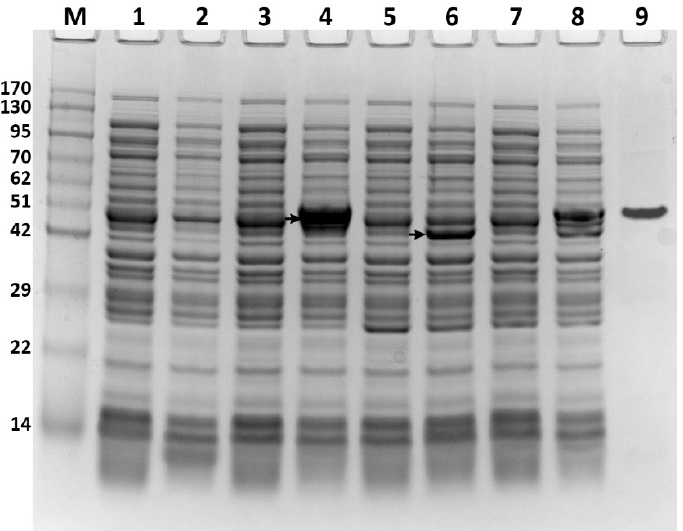
Figure 2. Analysis of the AtFab2 and AtFatA proteins expressed in E. coli by SDS-PAGE. Recombinant protein expression was induced by 0.1 mM IPTG for 3 h at 37 °C. Lane M, pre-stained protein molecular weight ladder; lane 1, uninduced cells extracts from E. coli BL21(DE3) harboring pET30a(+); lane 2, induced cells extracts from E. coli BL21(DE3) harboring pET30a(+); lane 3, uninduced cells extracts from E. coli BL21(DE3) harboring pET-AtFab2; lane 4, induced cells extracts from E. coli BL21(DE3) harboring pET-AtFab2; lane 5, uninduced cells extracts from E. coli BL21(DE3) harboring pACYC-AtFatA; lane 6, induced cells extracts from E. coli BL21(DE3) harboring pACYC-AtFatA; lane 7, uninduced cells extracts from E. coli BL21(DE3) harboring both pET-AtFab2 and pACYC-AtFatA; lane 8, induced cells extracts from E. coli BL21(DE3) harboring both pET-AtFab2 and pACYC-AtFatA; lane 9, purified recombinant His6-AtFab2. The positions corresponding to the AtFab2 and AtFatA proteins were indicated by arrows.